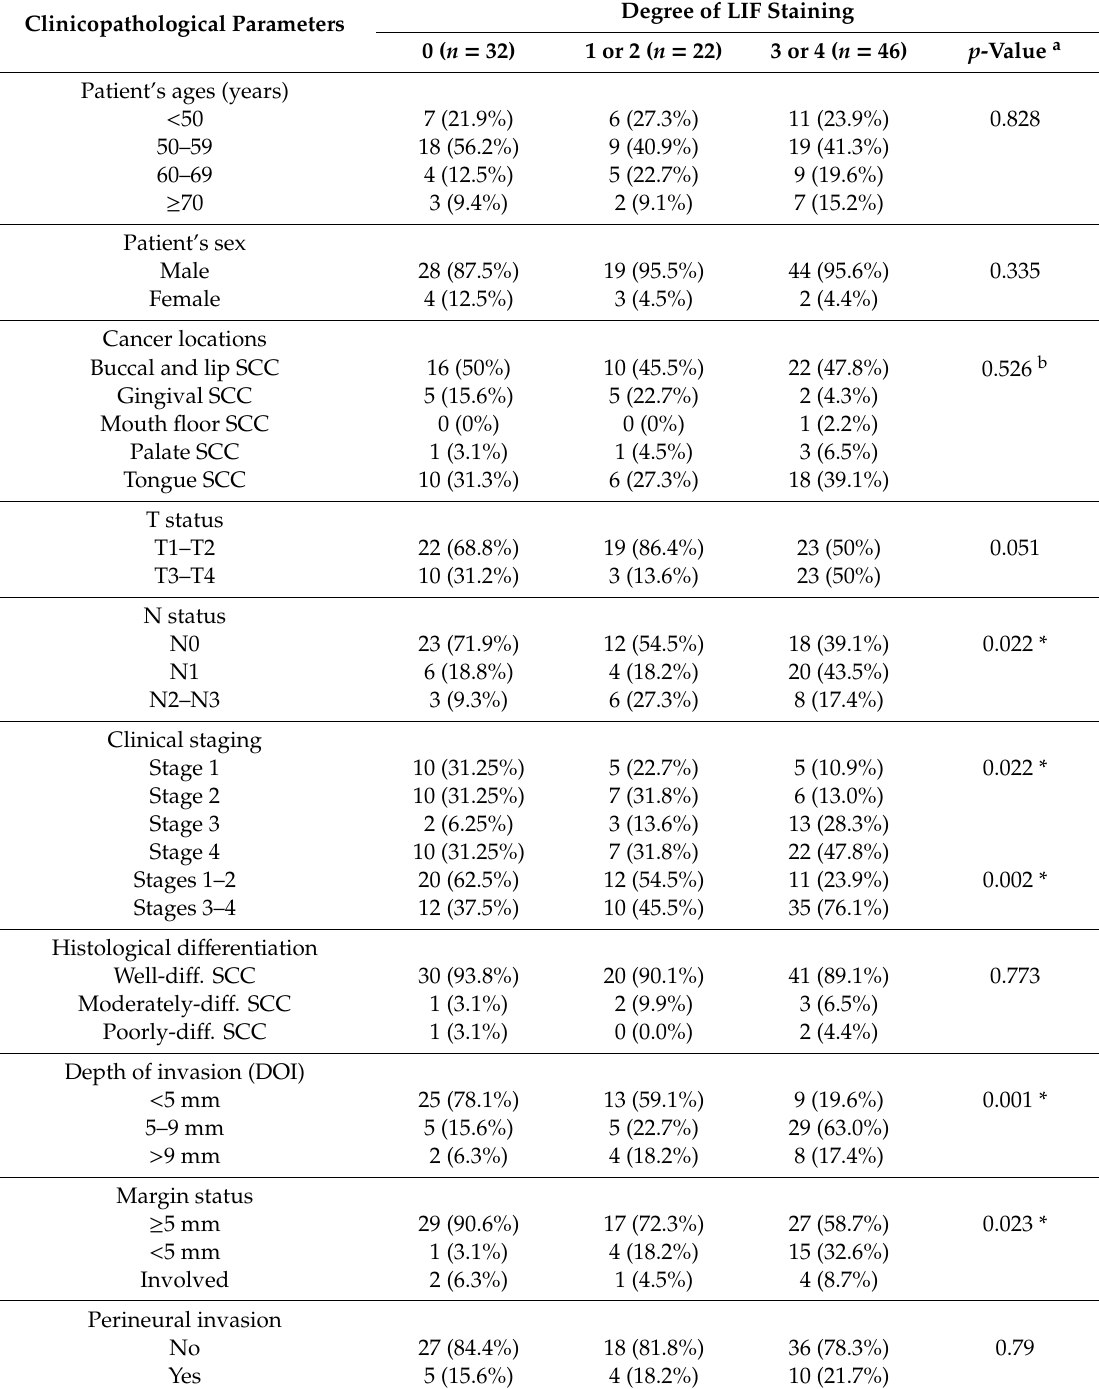
Table 1. Correlation between leukemia inhibitory factor (LIF) expression and clinicopathological